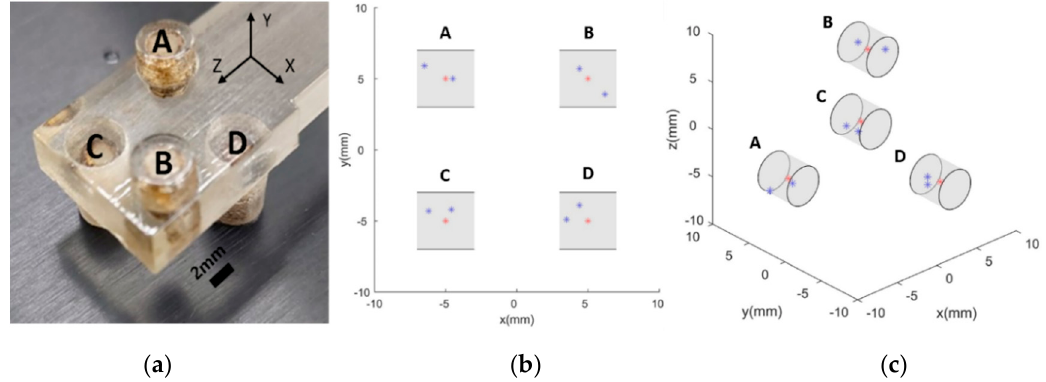
Figure 8. Experimentally obtained 3D localization; ( a ) phantom model, ( b ) 2D imaging on XY-plane, and ( c ) a side view of 3D imaging.